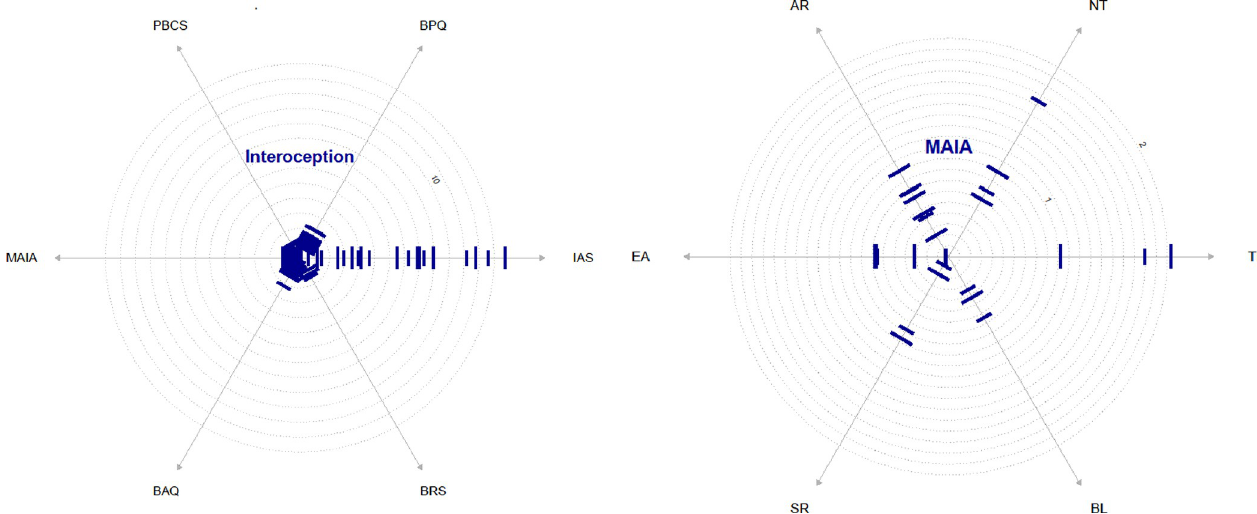
Fig 1. Radar charts with item locations on scale dimensions for all measures (left) and the MAIA-2 subscales in isolation (right). The dotted circles represent the grid of axis scaling. For clearer distinction, every second item is illustrated as having a different length. AR = Attention Regulation, NT = Noticing, TR = Trusting, BL = Body Listening, SR = Self-Regulation, EA = Emotional